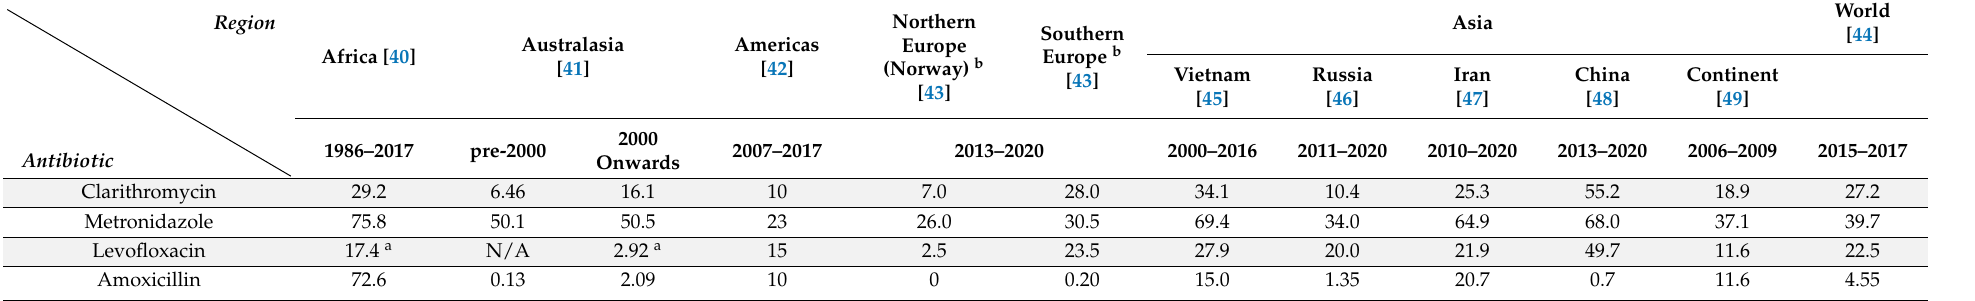
Table 1. Percentage of H. pylori strains studied showing primary resistance to key antibiotics in anti- H. pylori therapies around the